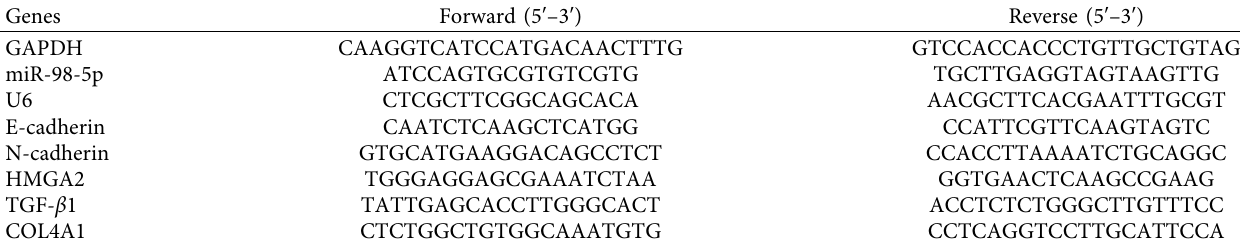
Table 1: Primers used for real-time